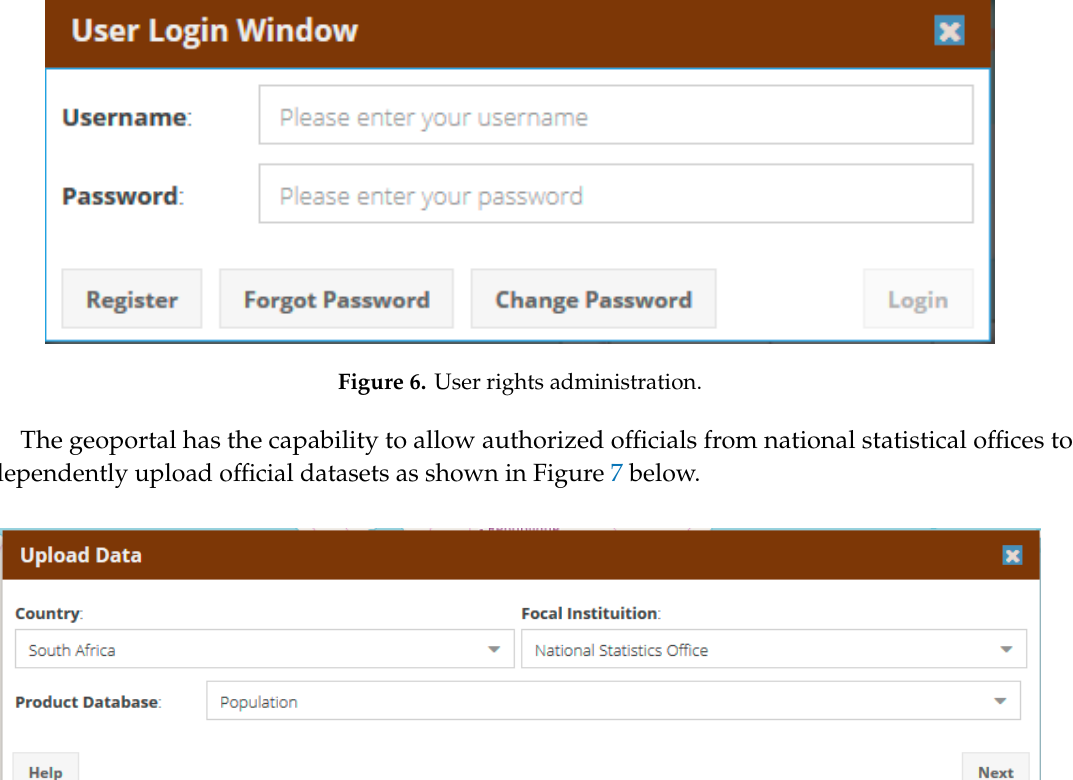
Figure 5. Base layers can be viewed on the maps and overlaid for visual and quantitative analysis.